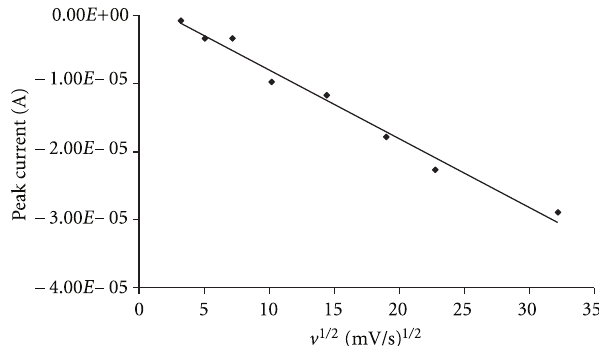
Figure 8: Dependence of the reduction peak current of 10 mM H 2 O 2 upon the square root of the potential sweep rate. 0.1 M phosphate bu ff er, pH =